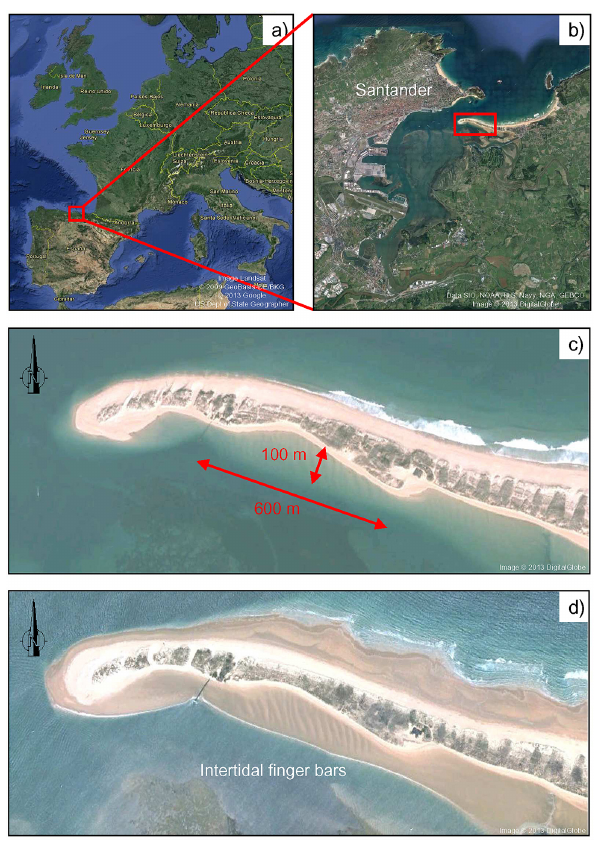
Figure 1. (a) Location of Santander, (b) map of the bay, (c) El Pun- tal at high tide, and (d) El Puntal at low tide. Images from Google Earth; Landsat; © 2009 GeoBasis-DE/BKG; © 2013 Google; US Dept of State Geographer; Data SIO, NOAA, U.S. Navy, NGA, GEBCO; © 2013